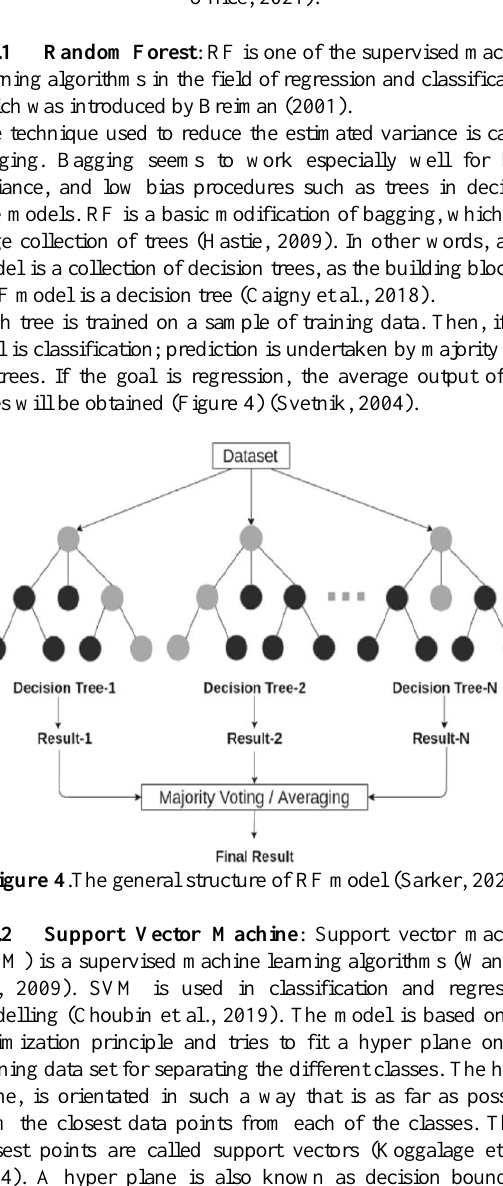
Figure 3 . Flooding and rising water level in residential areas due to heavy rain on May 17, 2021 (Calcasieu Parish Sheriff's Office, 2021).